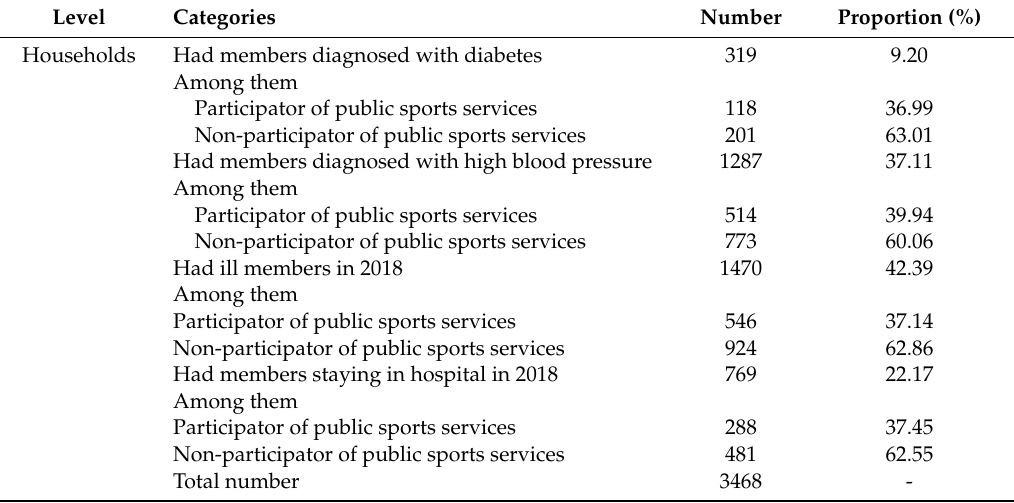
Table 2. Descriptive statistics of the variables related to public health in the